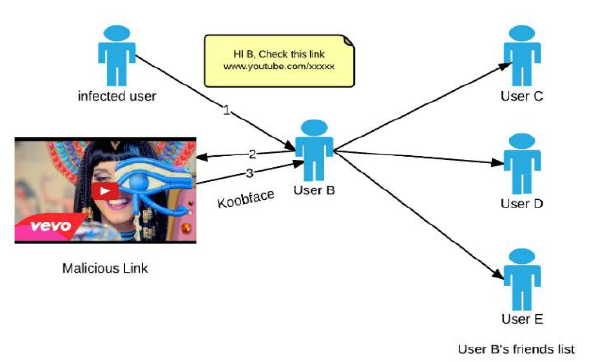
Figure 6. Koobface attack pattern